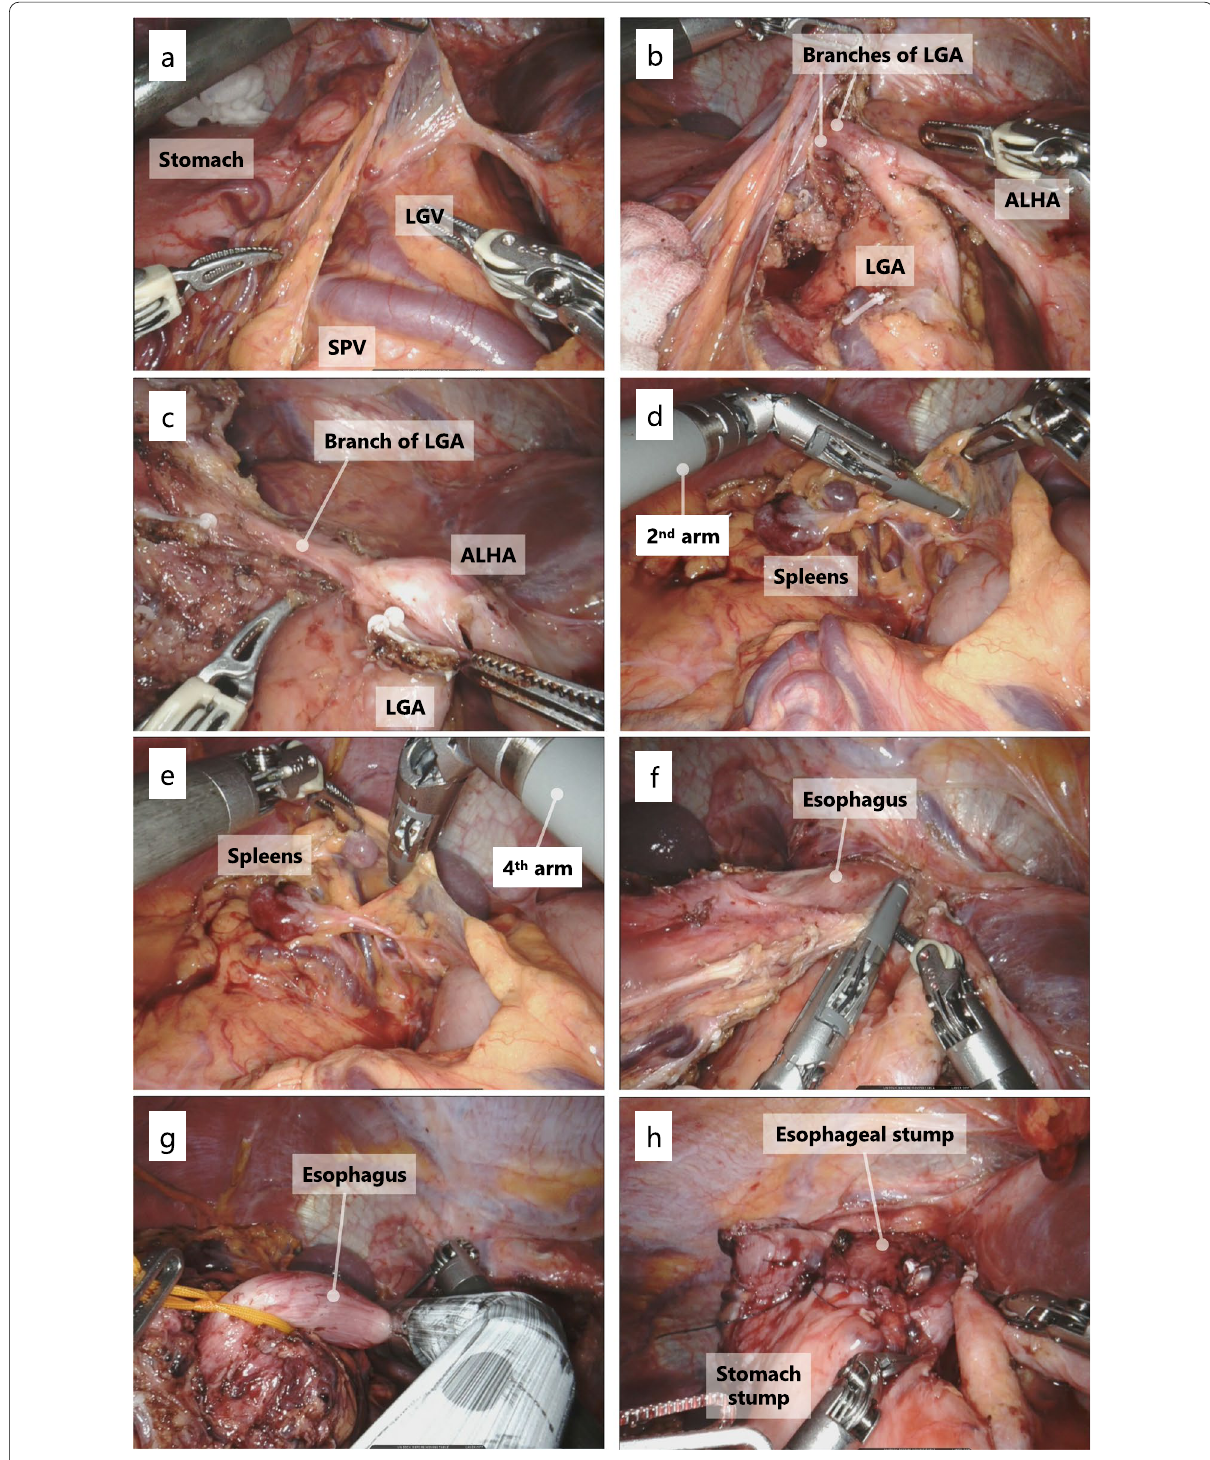
Fig. 5 Intraoperative findings. a Two LGVs drained into the SPV. b , c The LGA branched an ALHA and was itself divided into three branches. d , e A sealing device was attached to the second arm and fourth arm depending on the situation. f Transhiatal lower mediastinal lymphadenectomy was performed. g The esophagus was transected 4 cm above the esophagogastric junction. h Esophagogastrostomy was performed using the side overlap with fundoplication by Yamashita method. LGV left gastric vein, SPV splenic vein, LGA left gastric artery, ALHA accessory left hepatic